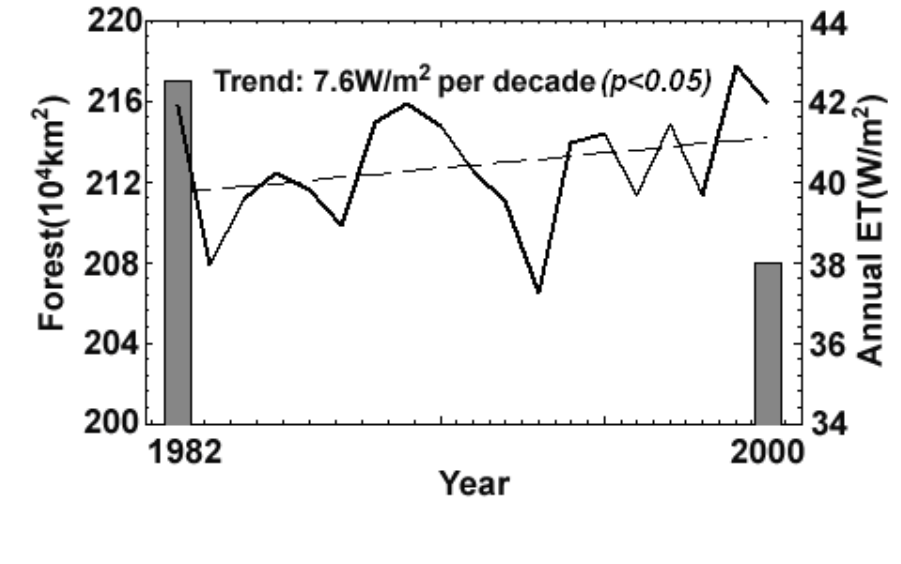
Figure 5. Relationship of forest cover and decadal ET during 1982–2000 in subarctic China (The bar graph shows the forest area. The solid and dashed lines show the annual ET and the linear trend of annual